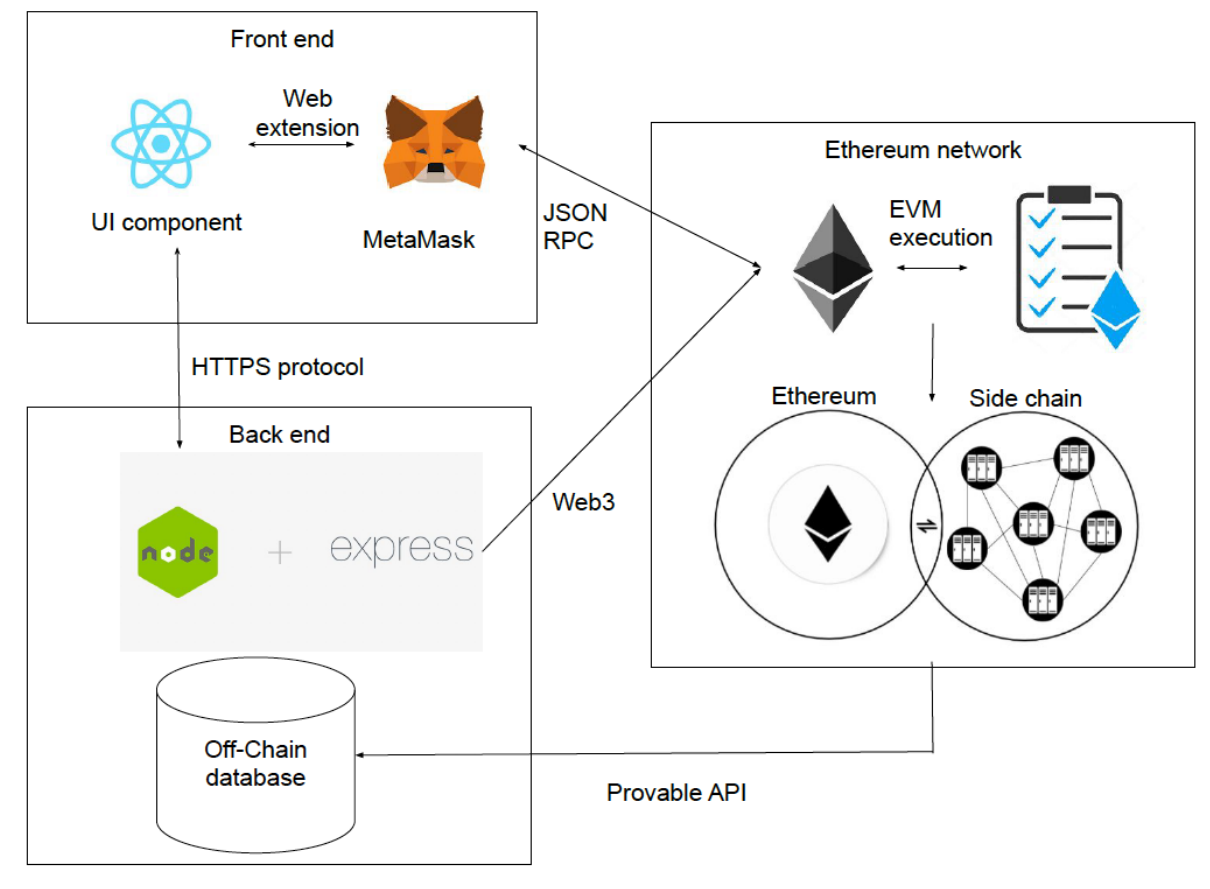
Figure 4. Overall system architecture of the framework, with React used for the user interface and NodeJS and an Express server used for the back-end processing server. Solidity was the smart contract language used to interact with a local Ethereum blockchain network. The Application Programming Interface is a set of functions and procedures allowing communication between the front-end user interface, back end server, blockchain network as well as access to functions and data of the system. The Ethereum Virtual Machine is the runtime environment for smart contracts in Ethereum. JavaScript Object Notation remote procedure protocol is a specification that defines several data structures and the rules around their processing. Interaction with the Ethereum blockchain starts with sending a request via JSON RPC. API: Application Programming Interface; EVM: Ethereum Virtual Machine; JSON: JavaScript Object Notation; RPC: remote procedure